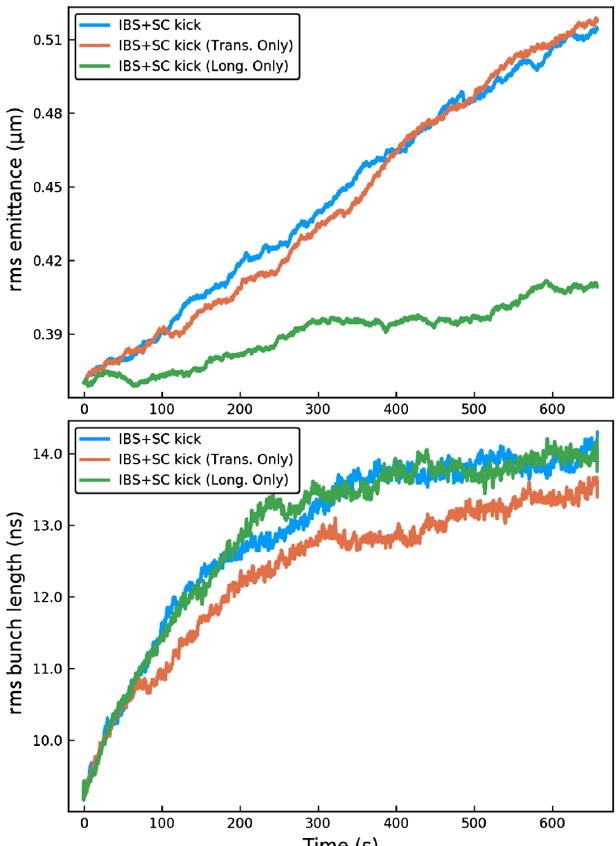
FIG. 8. Comparison of the effects of transverse and longitudinal SC kicks on the ion beam emittance and bunch length in